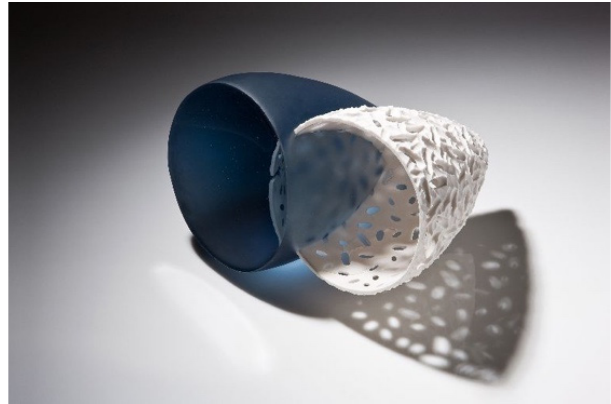
Figure 13. June Morrison, Embrace , 2009; bone china and kiln cast gaffer glass. Courtesy of the artist, used with permission.